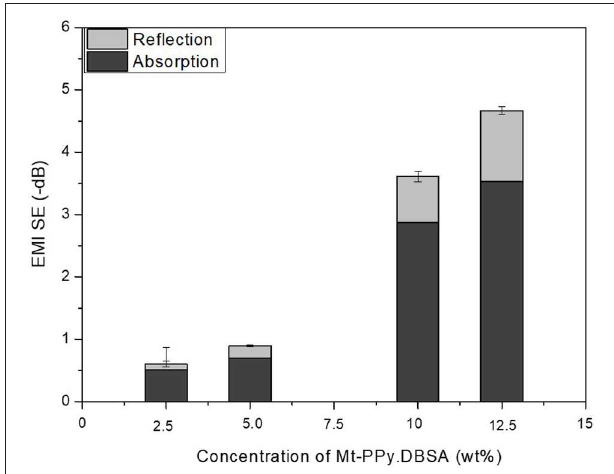
FIGURE 8 | Effect of conductive filler content on the total EMI SE average, absorption loss (SEA) and reflection loss (SER) of PVDF/Mt-PPy.DBSA membranes by solution casting with a thickness average of 0.25